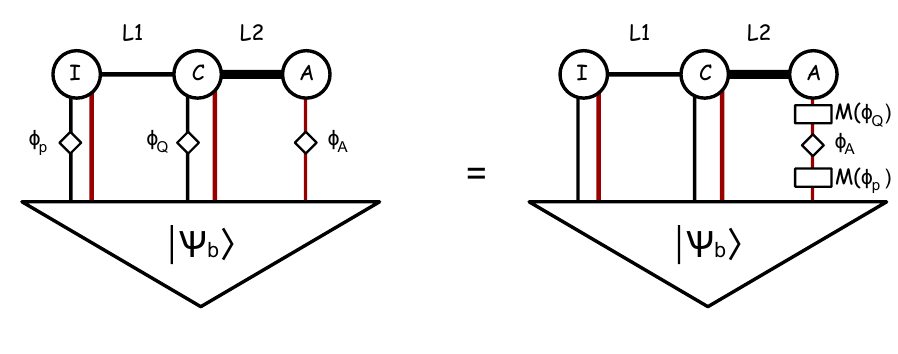
Figure 20. The reconstruction of operators in small probe regions P; Q to a region A , when P is part of the entanglement island I of A and Q is outside I . Notice the di(cid:11)erent location of operator insertions on the right side of the